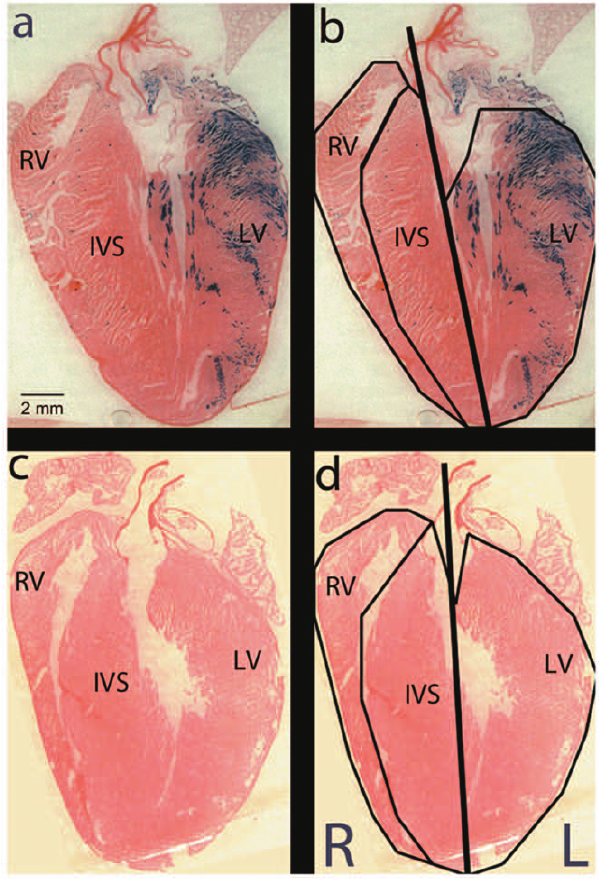
Figure 2. To quantify Pnmt expression, Pnmt + /Cre , ROSA26 + / b gal adult mouse heart images were partitioned into right and left heart. The line of separation originates from the apex and extends toward the base of the heart and through the aorta (bold line). Additional partitioning isolates the IVS from the RV and LV free walls (panel b and d). Each partition was then analyzed to determine the total pixels containing the blue XGAL + stain. The left heart shows heavy XGAL + staining when compared to the right side of the heart. Pnmt + / + , ROSA26 b gal/ b gal control heart shows no XGAL + staining (panel c and